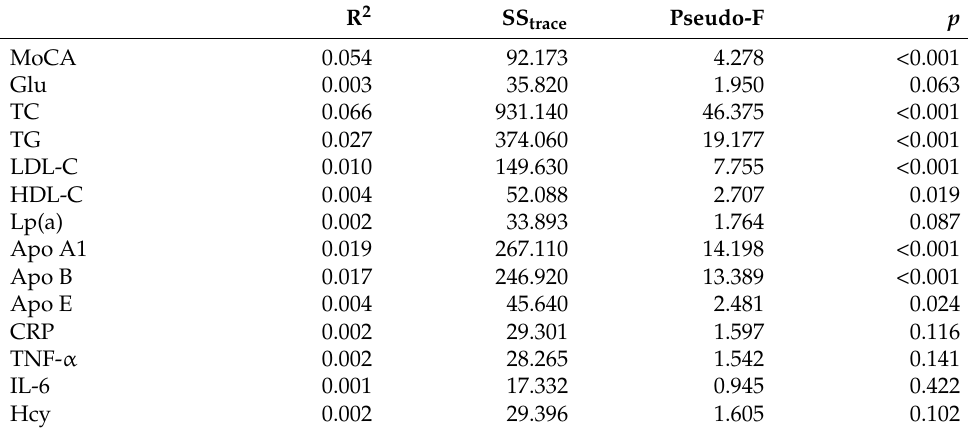
Table 3. Distance-based linear model (DistLM) of phospholipid matrix with MoCA score and biochemical parameters 1